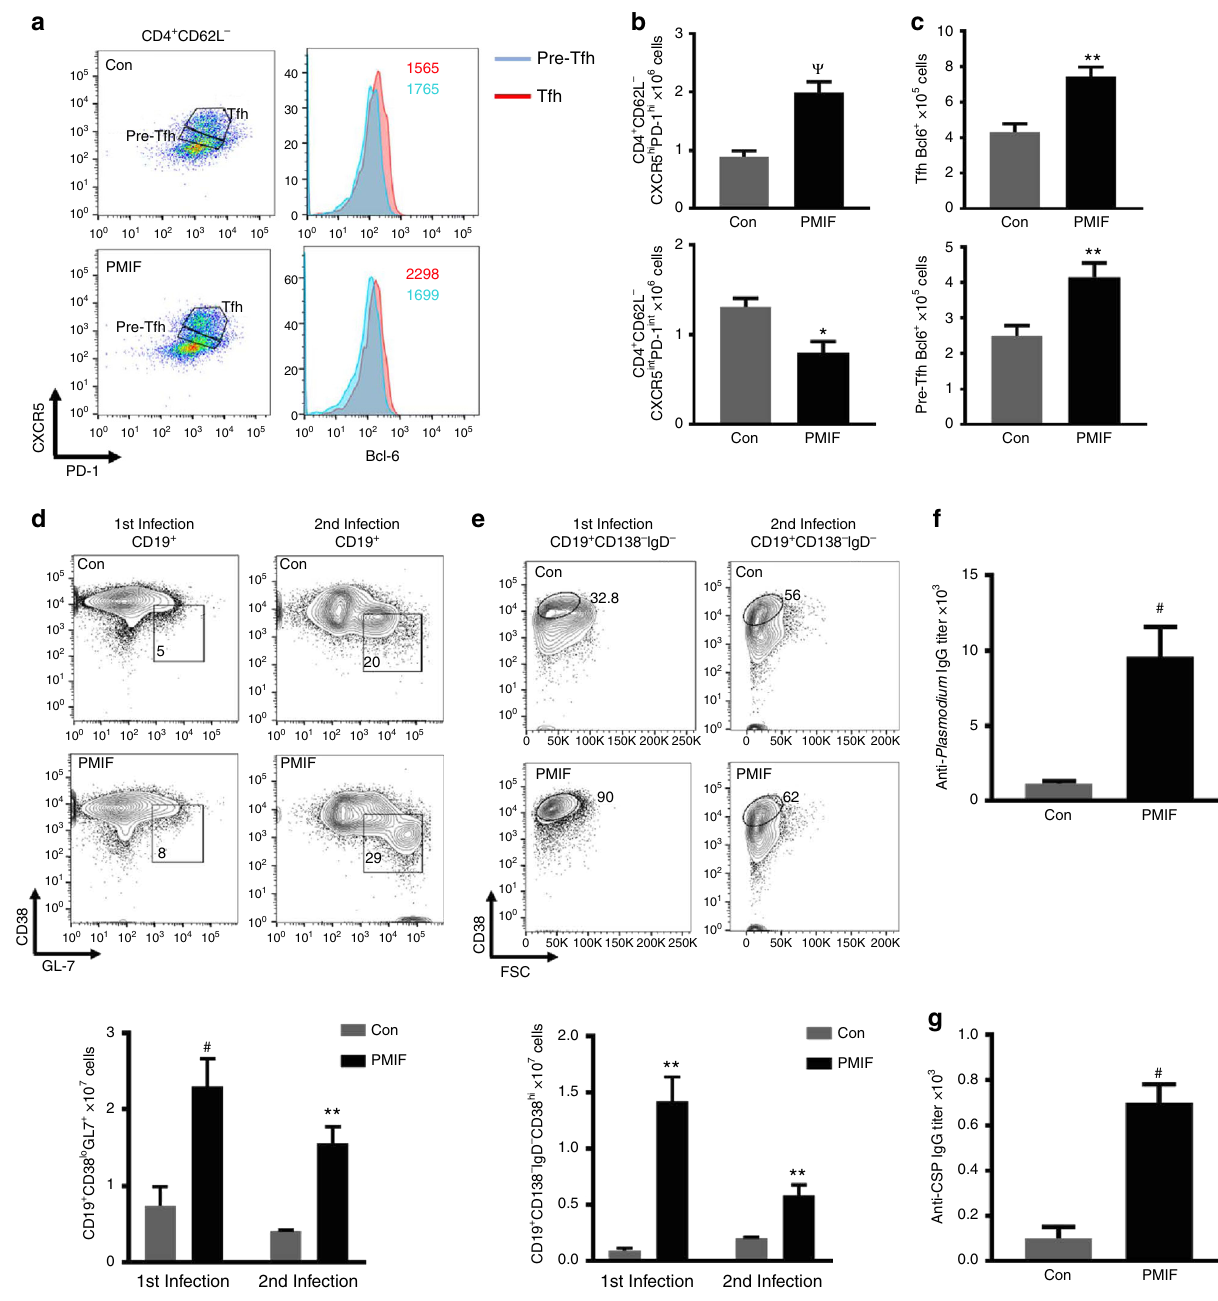
Fig. 6 PMIF inhibition enhances the development of CD4 Tfh, plasma cells, and anti- Plasmodium antibody responses. BALB/cJ mice immunized with replicons encoding Con RNA or PMIF RNA were infected with 2000 Pb AWT sporozoites and splenocytes isolated on day 7 after infection. a , b Representative plots of absolute numbers of Tfh cells (CD4 + CD62L − CXCR5 hi PD-1 hi ) and pre-Tfh cells (CD4 + CD62L − CXCR5 int PD-1 int ). c Expression of transcription factor Bcl-6 in Tfh and pre-Tfh cells for both groups of mice during fi rst Pb AWT infection. Results are from two separate experiments. Bars represent the mean of 6 mice ± SD; * p < 0.05, ** p < 0.001, Ѱ p < 0.0001 by Mann – Whitney test. d , e Representative plots and absolute number of germinal center (CD19 + CD38 lo GL7 + ) and memory B cells (CD19 + CD138 − IgD − CD38 hi ) after the fi rst and second infection. Results are from two separate experiments. Bars represent the mean of 6 mice ± SD; ** p < 0.001, # p < 0.0001 by Mann – Whitney test. Serum titers of speci fi c anti- Plasmodium blood - stage ( f ) and anti-CSP liver-stage antigen ( g ) IgG from immunized mice analyzed 1 week after the second infection with Pb AWT sporozoites. Data shown are from three and two independent experiments, respectively. Bars represent the mean of 10 mice ± SD; # p < 0.0001 by Mann – Whitney